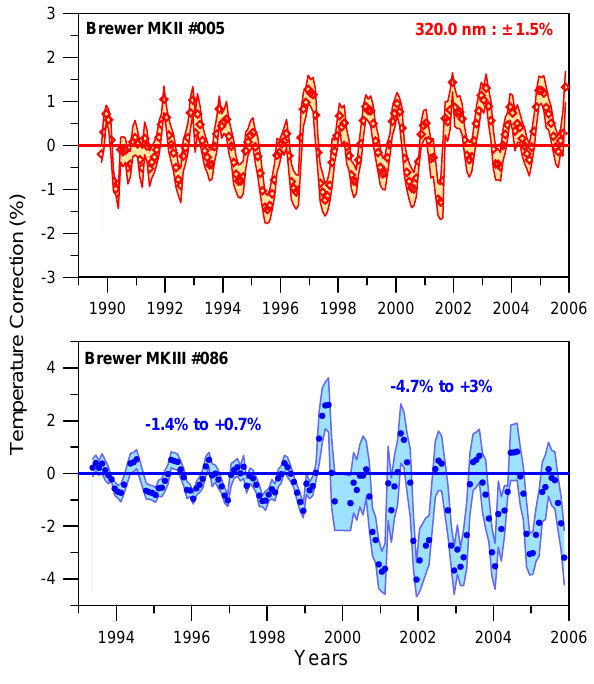
Fig. 7. Monthly means of the temperature corrections applied to the solar UV irradiance measurements conducted by the two Brewer spectroradiometers, during the entire period of their operation. The upper panel displays the correction for Brewer #005 (at 320nm) and the lower panel the correction for Brewer #086. The shaded areas represent the standard deviation ( ± 1 σ) of the mean.